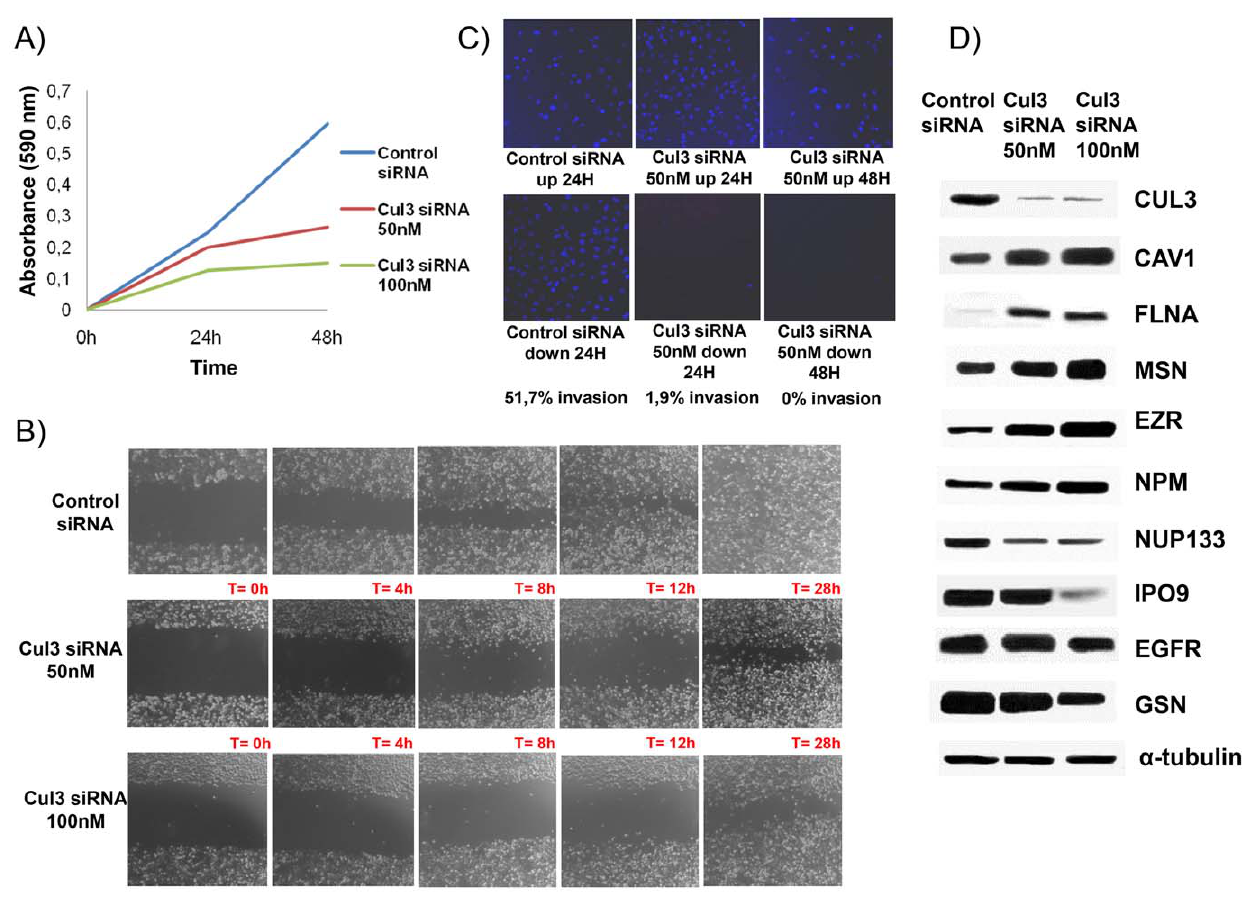
Figure 5. Functional analyses of the impact of Cul3 silencing on: A) proliferation, B) migration, and C) invasion. The average of duplicate experiments of each functional assay with siRNAs against Cul3 versus the control siRNA is represented in each panel. D) Immunoblotting of proteins found differentially expressed by SILAC upon Cul3 silencing on T24T cells. The results suggested that the differential expression of several of these proteins would be likely regulated by Cul3. Antibodies displaying a single predominant band at the expected molecular weights were accepted: Cul3, Cullin 3; CAV1, Caveolin 1; FLNA, Filamin A; MSN, Moesin; EZR, Ezrin; NPM, Nucleophosmin; NUP133, Nucleoporin 133; IPO9. Importin 9; EGFR, Epidermal Growth Factor Receptor; GSN, Gelsolin; and a -tubulin, was used as the loading control.